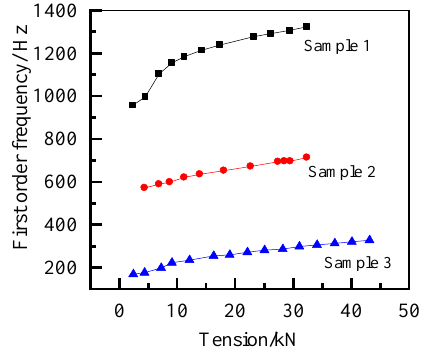
Figure 4. Test results under different tension forces.